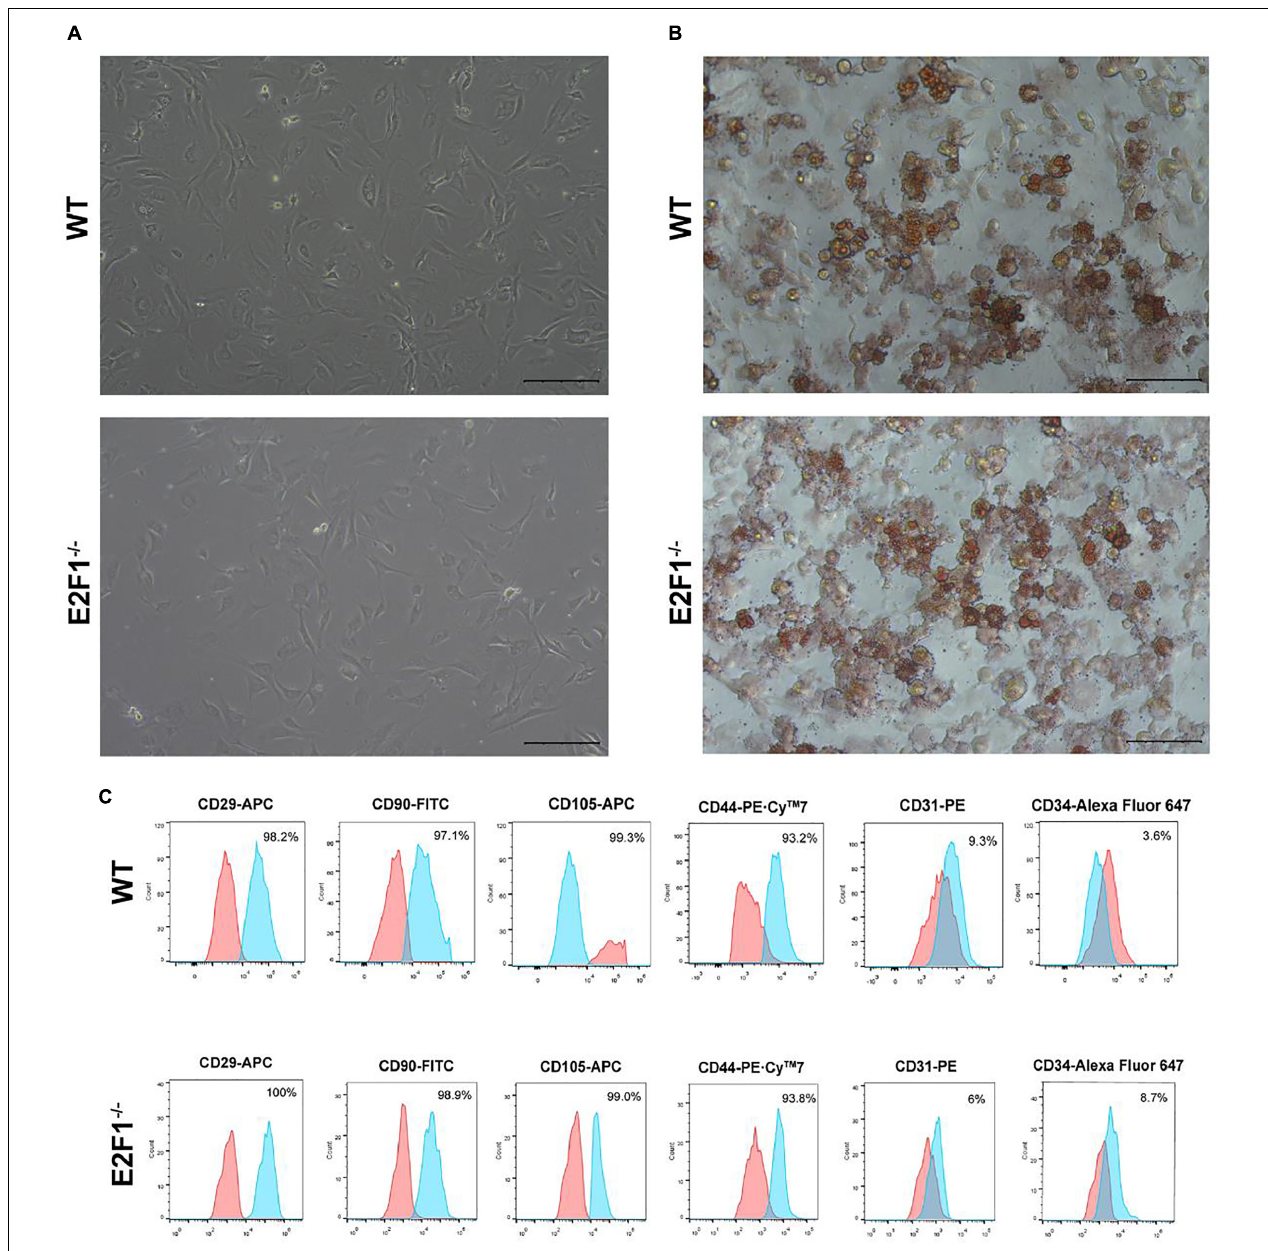
FIGURE 4 | Characterization of mice ADSCs. (A) Representative images of WT and E2F1 − / − ADSCs (P3). Scale bar, 100 µ m. (B) Adipogenic differentiation was analyzed by Oil Red O staining. Scale bar, 100 µ m. (C) Flow cytometry of phenotypic markers of ADSCs. The WT and E2F1 − / − ADSCs were positive for CD29, CD90, CD105, and CD44, and negative for CD31 and